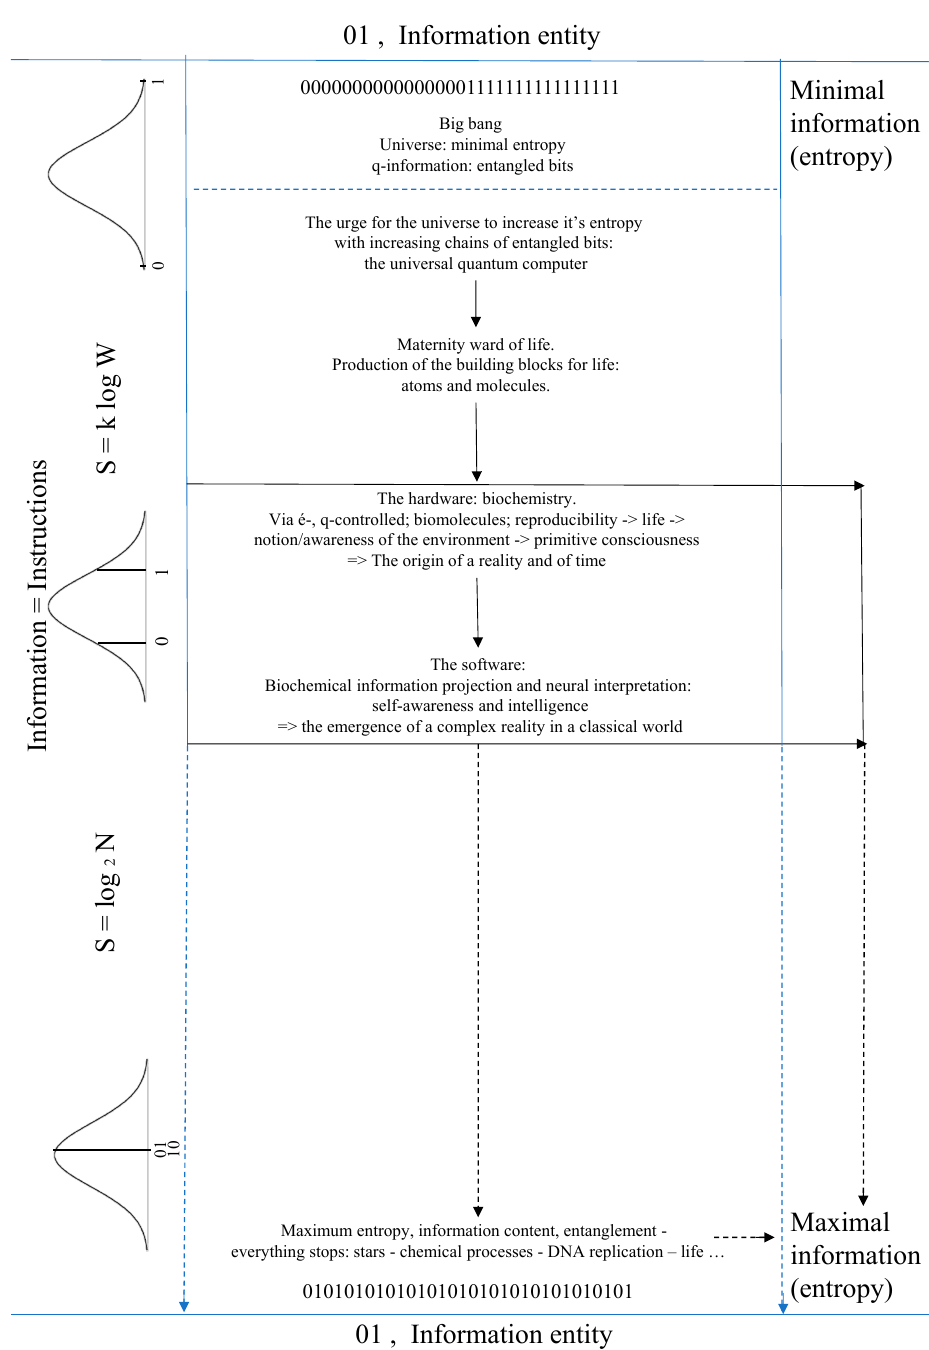
Figure A1. From minimal to maximal entropy and information. (Graphics Simon